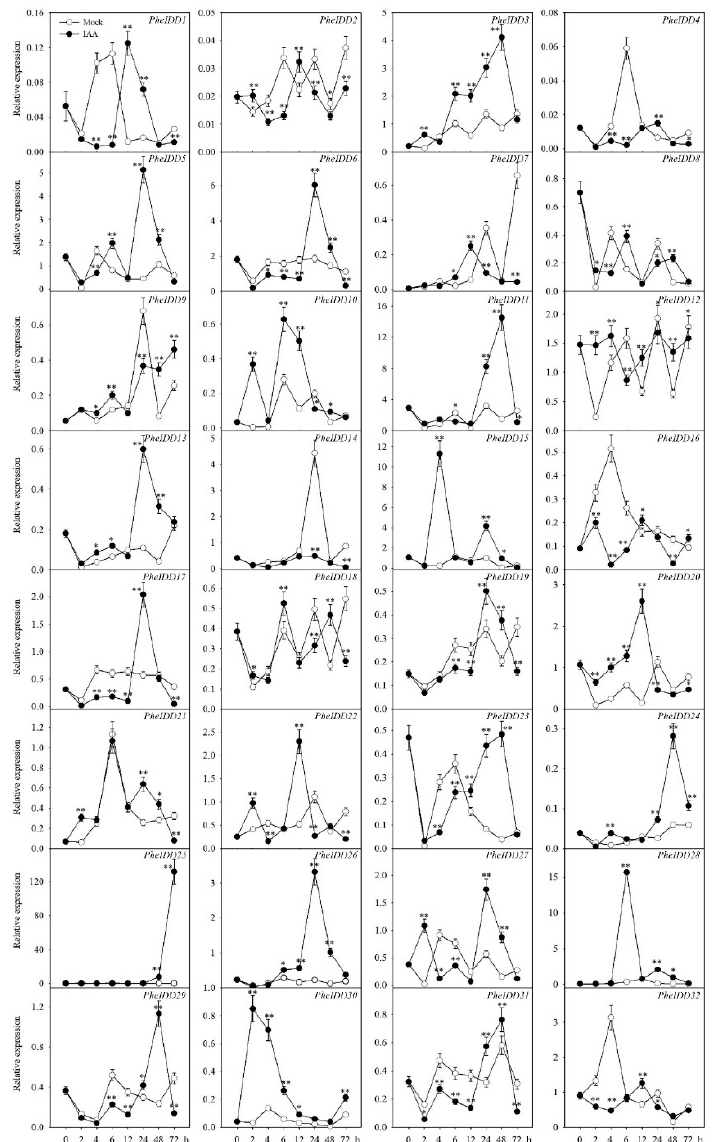
Figure 9. Expression patterns of PheIDD family genes under IAA treatment. Samples were harvested at 0, 2, 4, 6, 12, 24, 48, and 72 h after treatment. The PheNTB gene was used as a reference. The qRT–PCR results were obtained from three biological and three technical replicates. Five 0.6-cm sections of the stem base were harvested per replicate. Values are means ± SD. At a given time point, asterisks indicate a significant difference in expression between IAA treatment and Mock treatment based on LSD multiple comparisons. * p < 0.05; ** p <